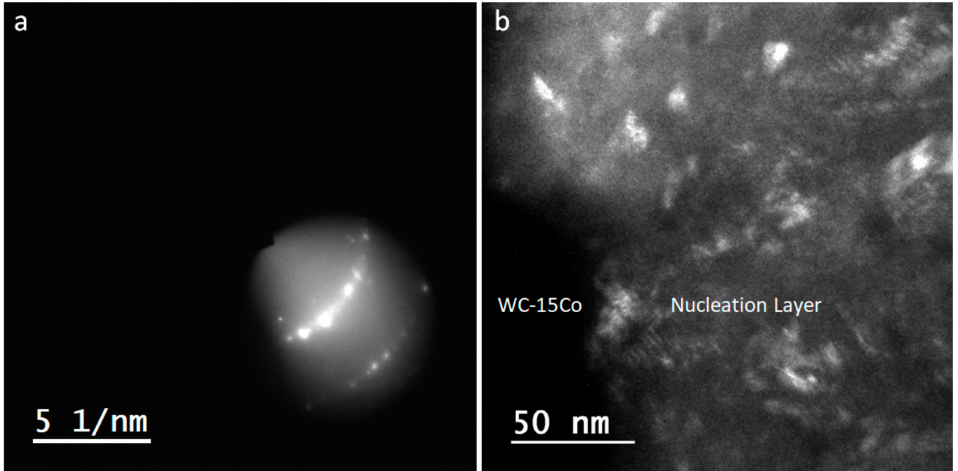
Figure 9. Dark field of the WC/diamond interface (nucleation layer) ( b ) recorded using the diffraction spots shown in ( a